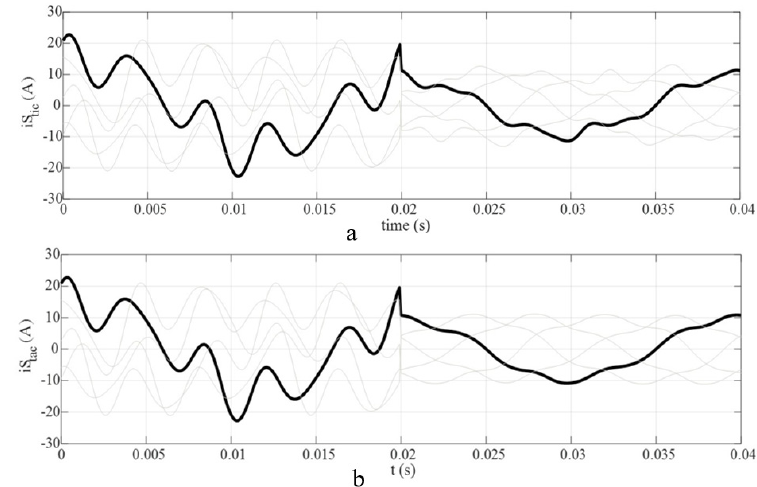
Figure 5. ( a ) Supply currents before/after instantaneous compensation (TIC). ( b ) Supply currents before/after average compensation (TAC). Compensation at t = 0.02 s.